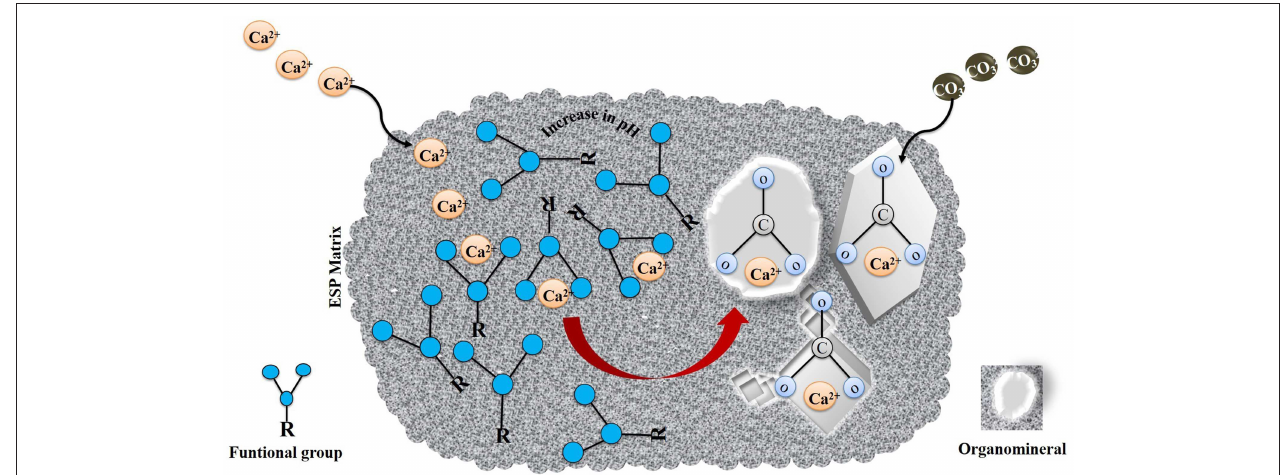
FIGURE 3 | Schematic illustration of BMM. Adapted from Dupraz et al.